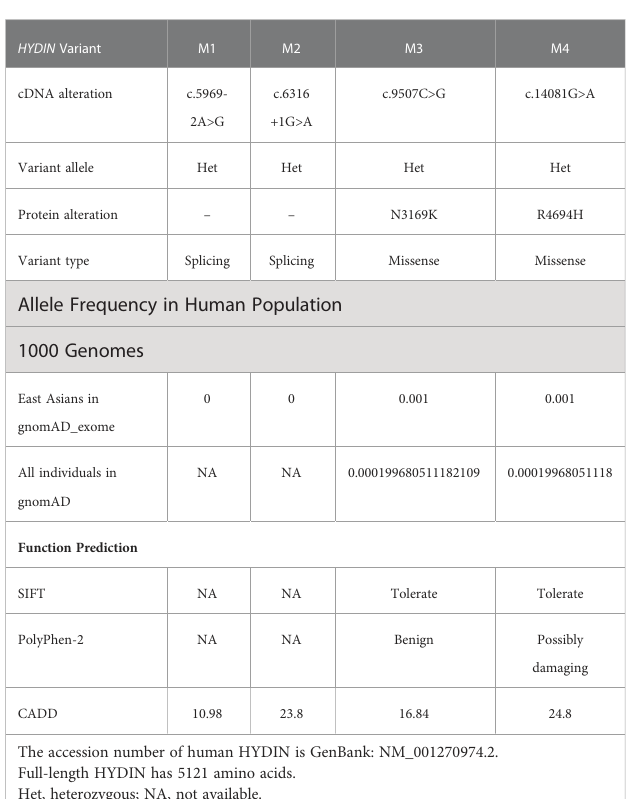
TABLE 1 Bi-allelic variants of HYDIN variants identi fi ed in Chinese men.